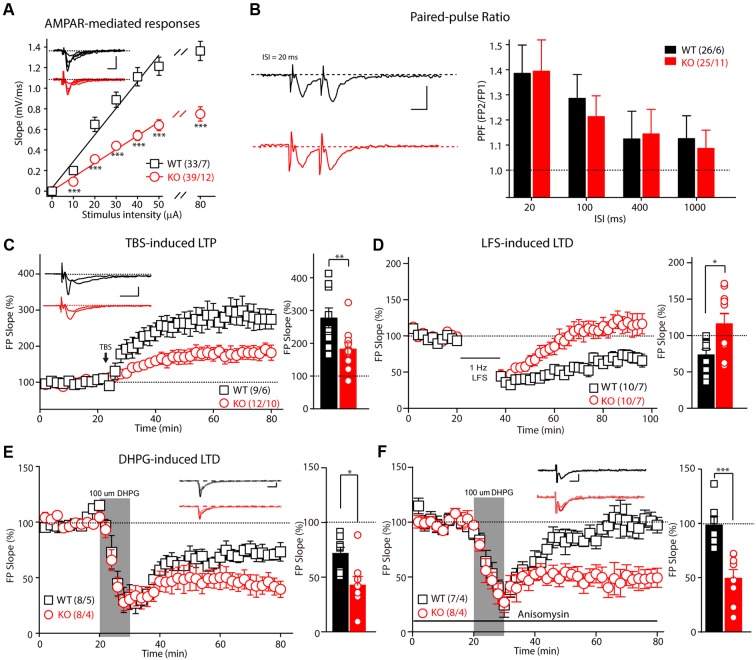
Impaired basic synaptic transmission and long-term plasticity in hippocampal CA3–CA1 synapses in Fmr1 KO rats. (A) The α-amino-3-hydroxy-5-methyl-4-isoxazolepropionic acid receptor(AMPAR)–mediated field excitatory postsynaptic potential (fEPSP) and the input-output curve were reduced in 8-week-old Fmr1 knockout (KO) rats. The initial slopes of the evoked fEPSP were plotted as a function of the stimulus intensity. (B) Left: Representative fEPSP traces from the control and Fmr1 KO rats evoked by two consecutive stimuli with a 20-ms ISI. Right: Paired-pulse facilitation was normal in the 8-week-old KO rats. (C) The theta-burst stimulation (TBS)–induced long-term potentiation (LTP) was impaired in the 8-week-old KO rats. The inset (left panel) shows representative traces before and after LTP induction. The mean fEPSP slopes averaged 50–60 min after LTP induction in the wild-type (WT) and KO rats (Student’s t-test; right). (D) The low-frequency stimulus (LFS)–induced long-term depression (LTD) was impaired in the 8-week-old KO rats. (E)
Fmr1 KO rats showed an enhanced 3,5-dihydroxyphenylglycine (DHPG)–induced LTD (left: represented traces of WT and KO rats). (F) The protein synthesis inhibitor anisomycin blocks the DHPG-induced LTD of the WT rats but has no effect on the Fmr1 KO rats. All data are presented as mean ± standard error of the mean (SEM). The scale bars represent 10 ms, 1 mV (∗p < 0.05, ∗∗p < 0.01, ∗∗∗p < 0.001; ns., not significant. The number of hippocampal slices (left) and rats (right) used in each experiment is indicated in parentheses).